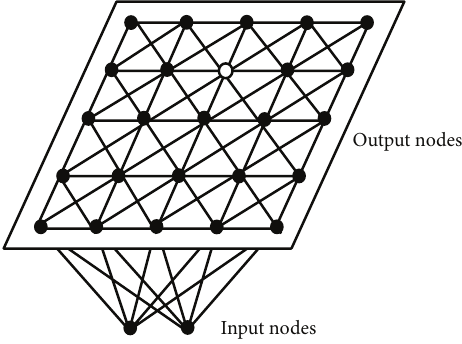
Figure 1: A 4 × 4 Kohonen’s self-organizing